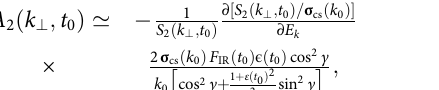
grams measured along the IR polarization, for the IR-oriented parallel ( a , c ) and perpendicular ( b , d ) to the major axis of the XUV ellipse. From the spectrogram, we extract the intensity of the IR fi eld I IR and the relative peaks of the XUV x and y spectrograms. For the pulse in Fig. 2a, we obtain I IR ¼ 3 : 3 ´ 10 12 W/cm 2 and the peak of the y component is retarded with respect to the x component by t 0 ; y (cid:2) t 0 ; x ¼ 70 : 7 as. For the pulse in Fig. 2b, we fi nd I IR ¼ 3 : 3 ´ 10 12 W/cm 2 and t 0 ; y (cid:2) t 0 ; x ¼ 22 : 2 as. Using a standard FROG-CRAB retrieval algorithm 26 , we may fully characterize these temporal pro fi les, including their duration and chirp. In the absence of chirp, one can also use the average signals recorded perpendicular to the IR polarization, minimizing distortions associated with the Coulomb-laser coupling 27 and fi nite-IR-pulse duration effects. These average signals are shown as the blue curves in the bottom panels of Fig. 3. For the pulse in Fig. 2a, they yield the durations of τ x ¼ 239 as for the x component and τ y ¼ 225 as for the y component. For the pulse in Fig. 2b, the extracted values were τ x ¼ 247 as and τ y ¼ 243 as. The different durations and time centers between the temporal pro fi les of the x and y components naturally make the ellipticity of the XUV pulse time dependent.